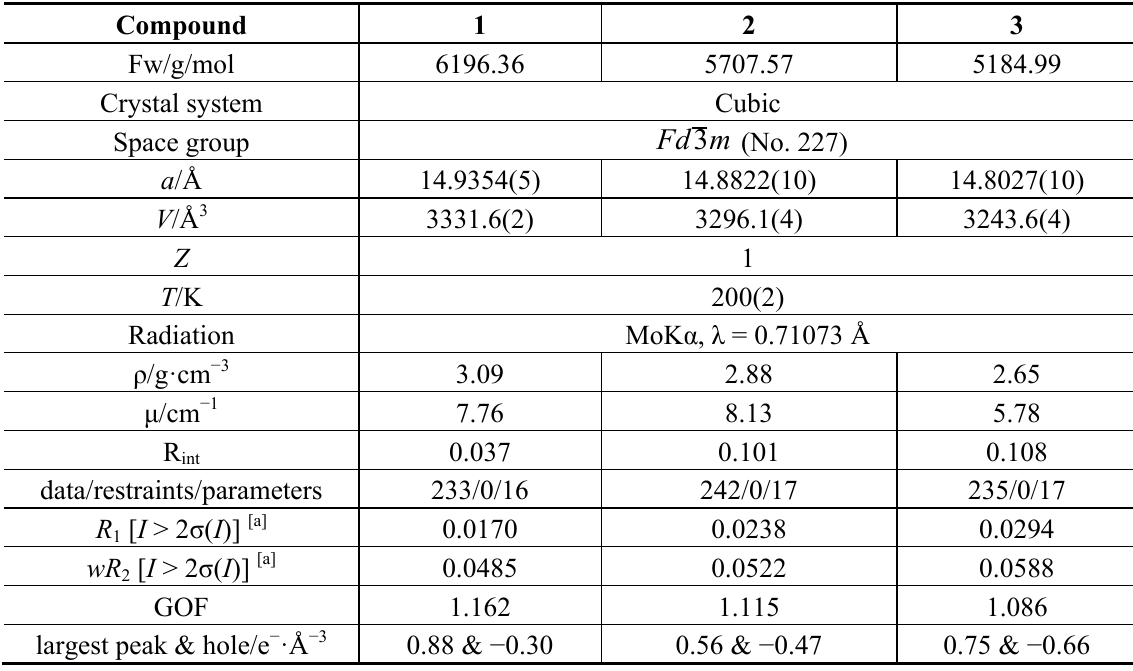
Na Ga Si 8 16 22.7